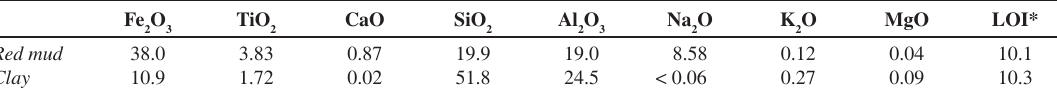
Table 1. Chemical composition (wt %) of the raw